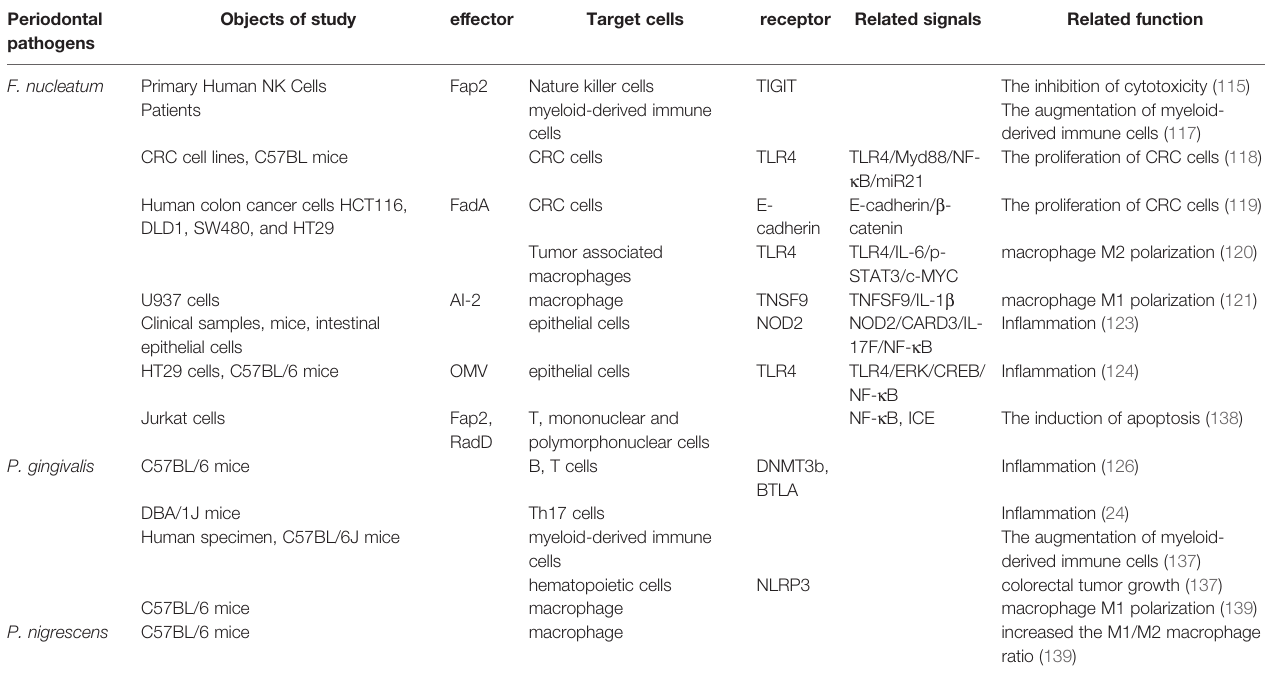
TABLE 3 | Main studies about the effects of periodontal pathogens on the intestinal immune